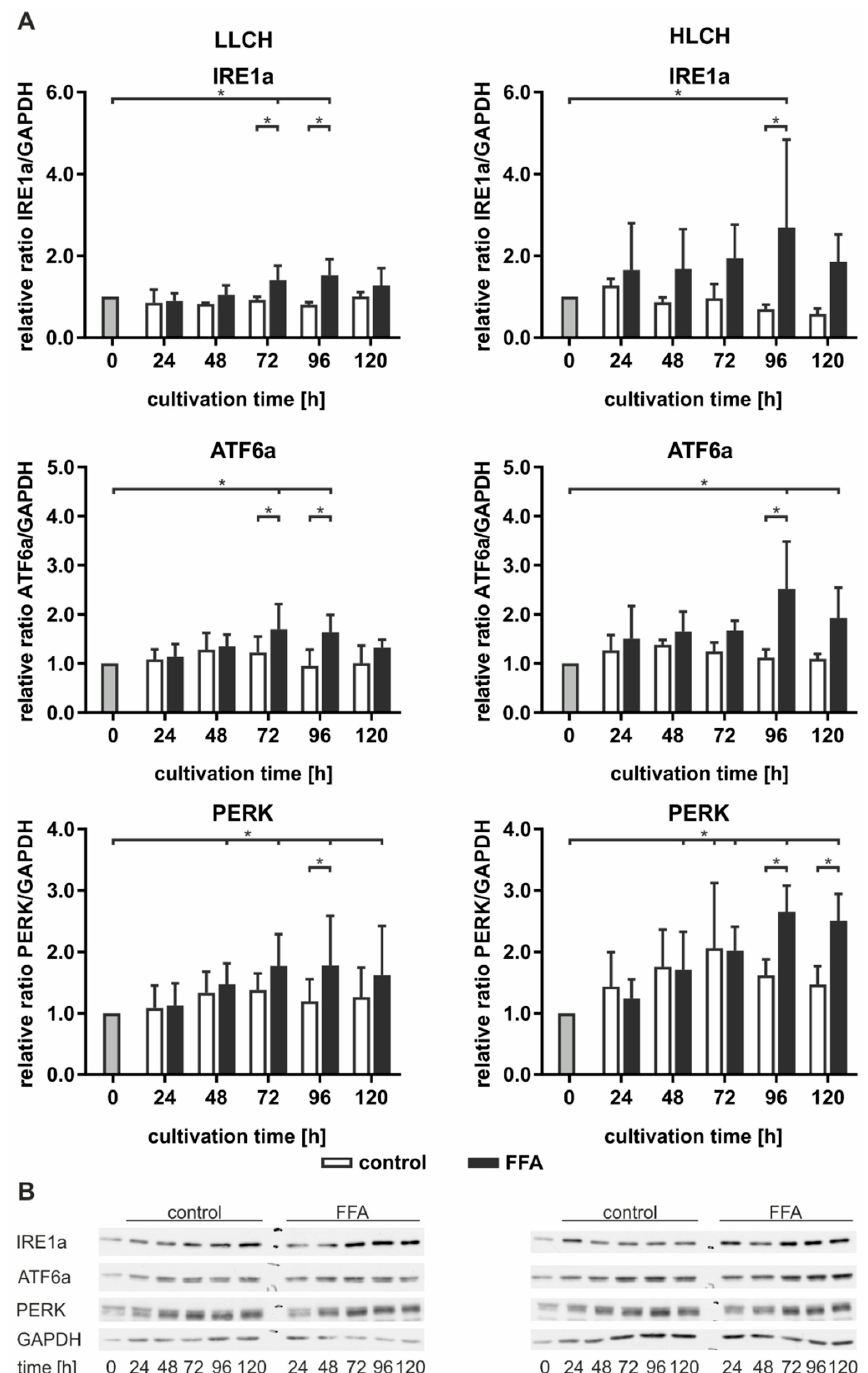
Figure 6. Prolonged lipid accumulation over 5 d led to lipid level-dependent endoplasmic reticulum (ER) stress and activation of the unfolded protein response (UPR). The UPR signaling targets IRE1a, ATF6a, and PERK were quantified by Western blot analysis in the LLCH (donors 1–3) and HLCH (donors 4–6). GAPDH was used as a reference protein. ( A ) Densitometrically analysis of Western blots. Data are shown as the means ± SD, n = 3, two-way ANOVA, and post hoc Dunnett or Bonferroni analysis. A p value of 0.05 or less (*) was considered significant. For the details on the statistical evaluation, see Table S1F. ( B ) Representative Western blots from donor 1 and 5 show IRE1a (130 kDa), ATF6a (90 kDa), PERK (140 kDa), and GAPDH (36 kDa) signals in the control and FFA-treated PHHs. For further Western blots, see Figures S2 and S3.